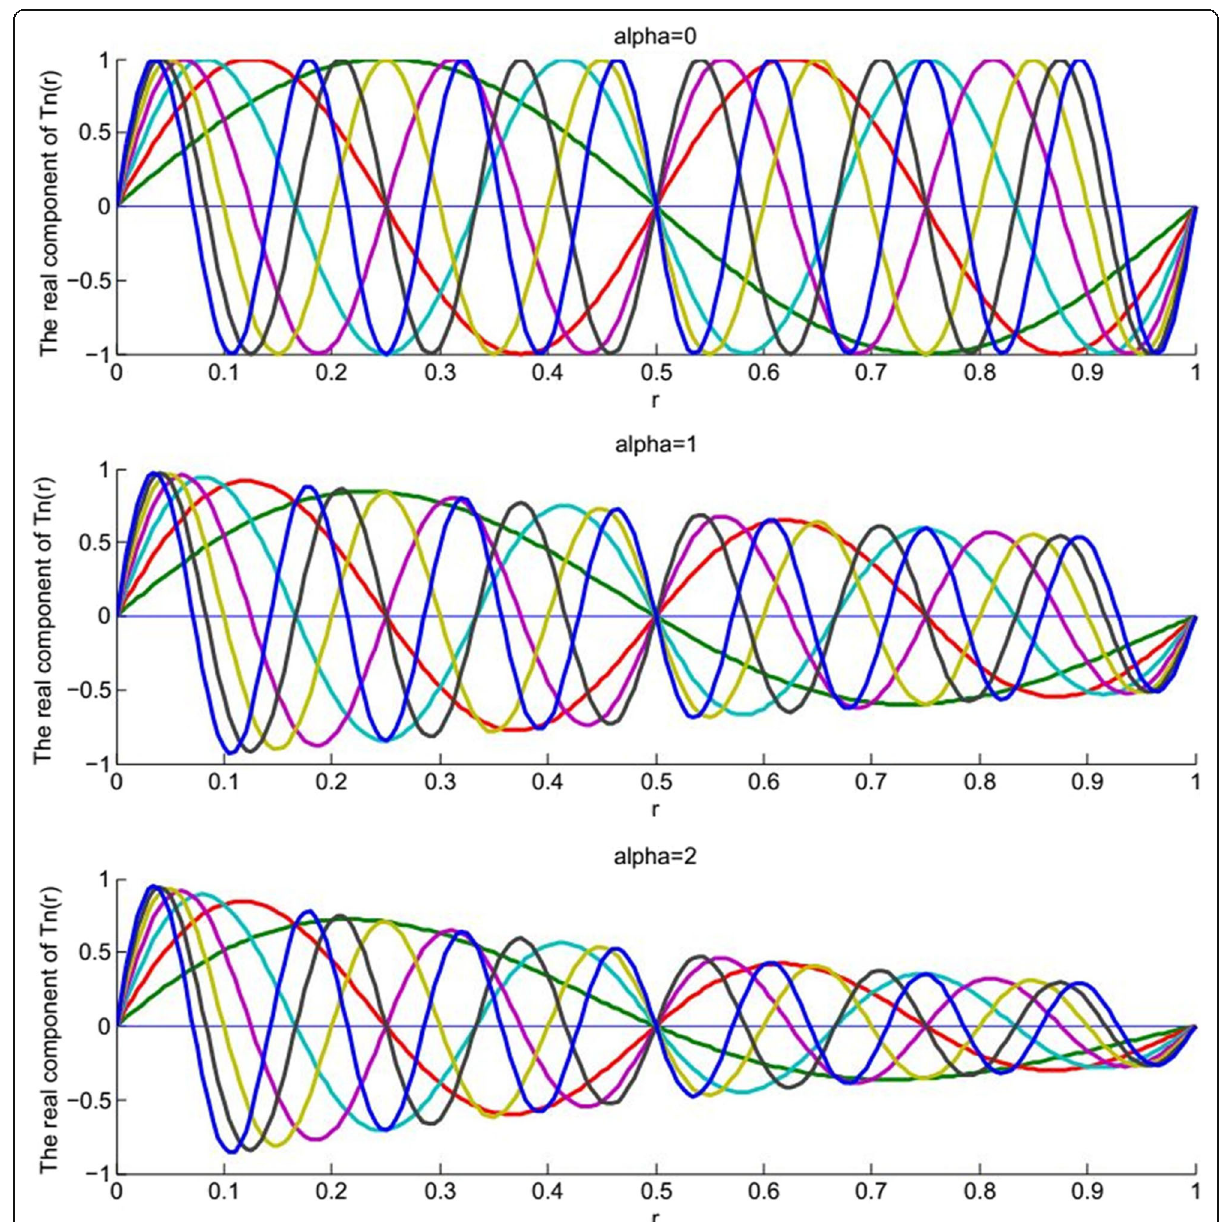
Fig. 4 Curve distribution of the MEFMs under different parameters in spatial